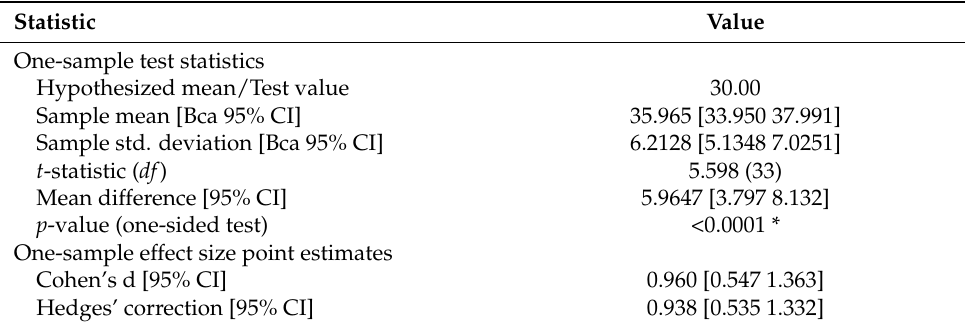
Table 7. One-sample t- test summary for the Flesch readability